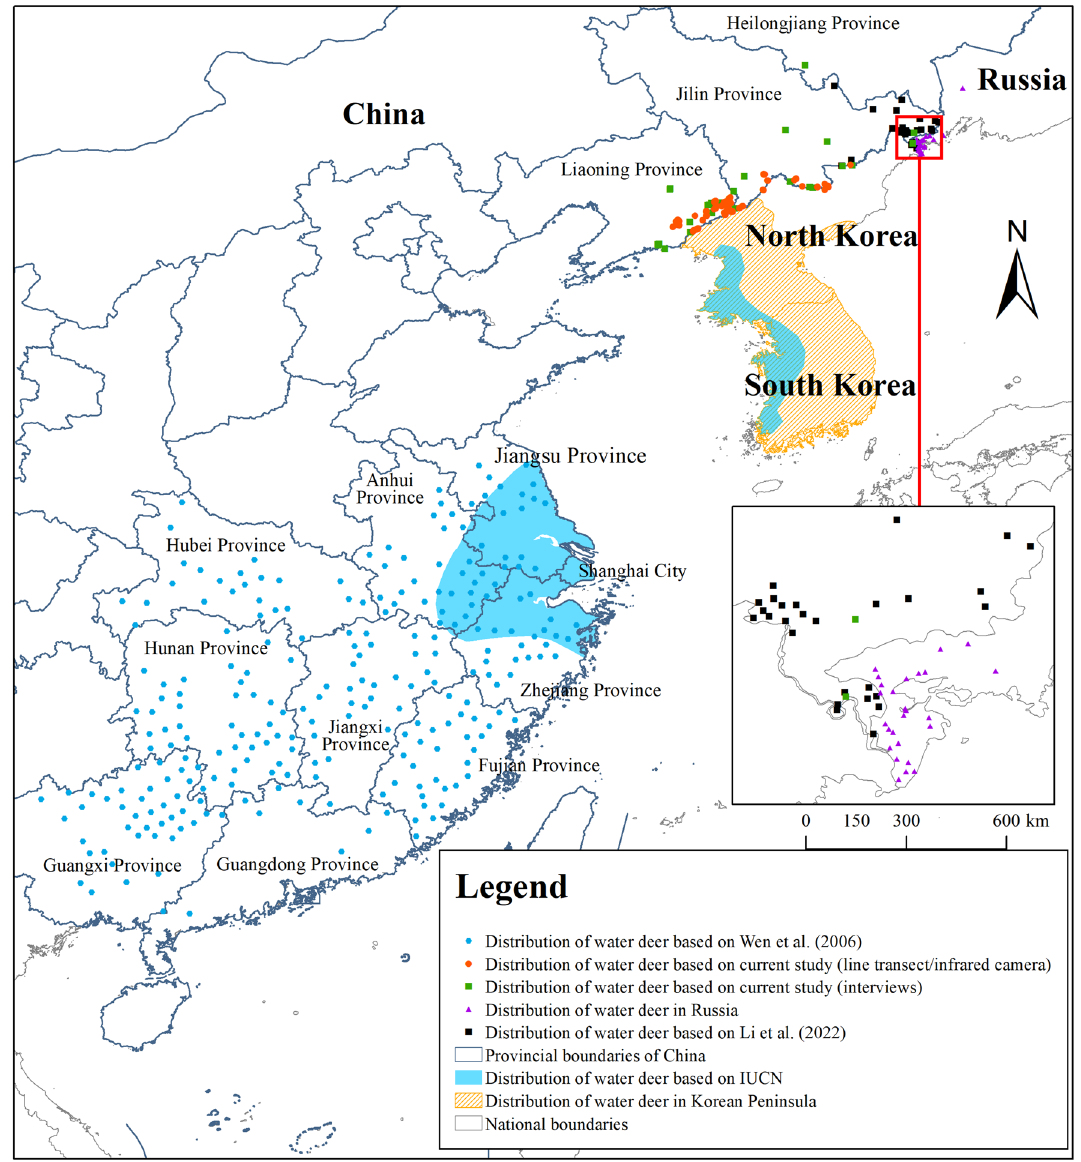
Figure 4. The distribution status of water deer in Northeast China and its surrounding areas. The blue points reflects the distribution of water deer in the south China which performed in 2006 62 . The orange and green points reflect their distribution in Northeast China in current study. The purple points reflects their distribution in Russia 47,48 . The black points is the distribution of water deer based on Li et al. 64 . The blue areas is their distribution based on IUCN 40 . The orange areas with diagonal reflects their current distribution in the Korean Peninsula 34 . This map was generated with ArcGIS 10.7 (Environmental Systems Research Institute, Inc. in Redlands, California, USA. URL: https:// www. esri. com/ en- us/ arcgis/ produ cts/ arcgis- deskt op/ overv iew).